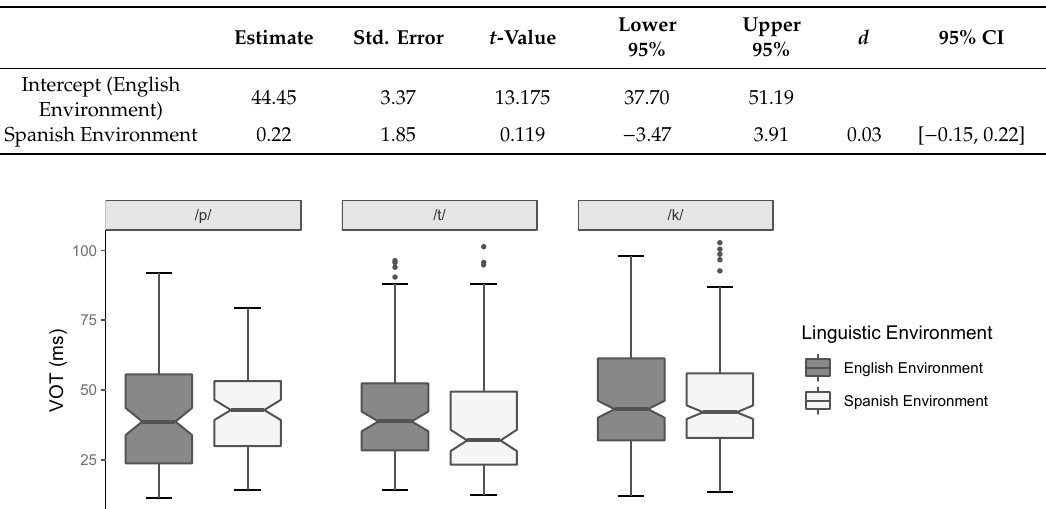
Table 2. Voice Onset Time (VOT) Model Fixed Effects.